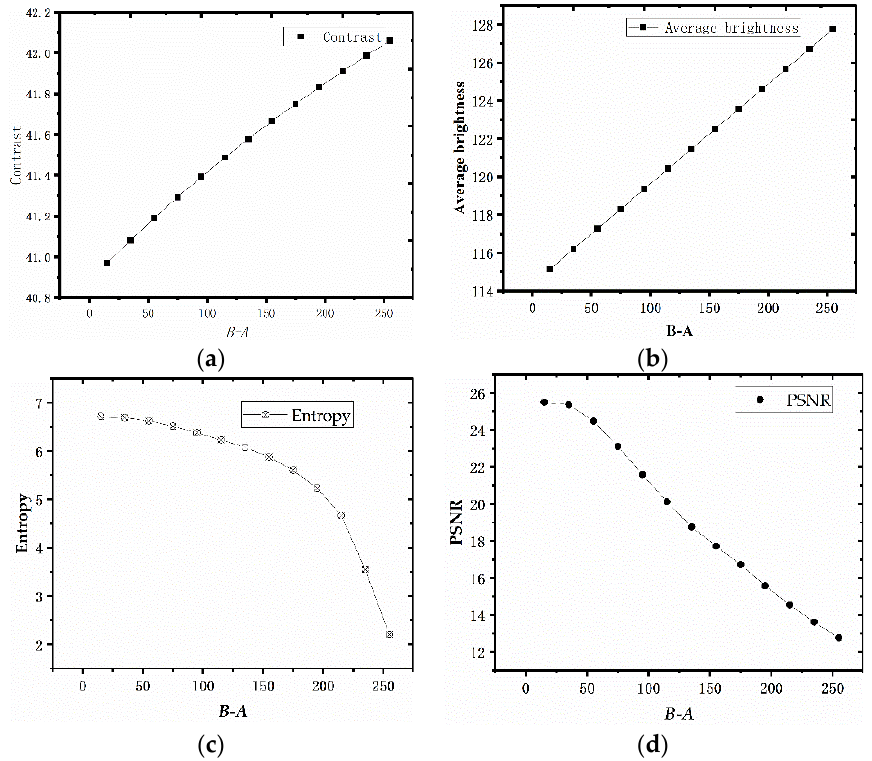
Figure 6. The plot of output image metrics versus B − A : ( a ) contrast; ( b ) mean brightness; ( c ) entropy; ( d ) PSNR. ( d )